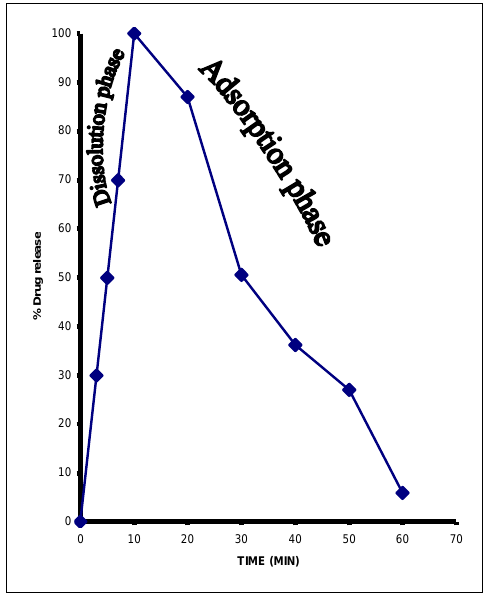
Figure 1: The percent of alpha-tocopherol acetate released from kaolin adsorbent at pH 1.2 before incubation period.